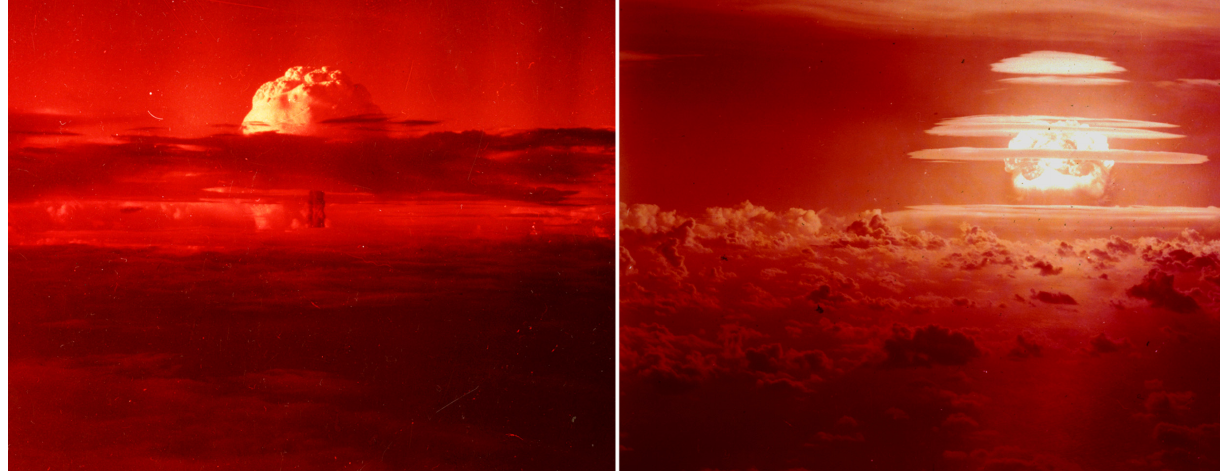
Figure 2: Mushroom clouds from the Ivy Mike, 1952 ( left ), and Castle Bravo, 1954 ( right ), thermonuclear blasts. Images courtesy of the National Archives, RG 374: Records of the Defense Threat Reduction Agency,